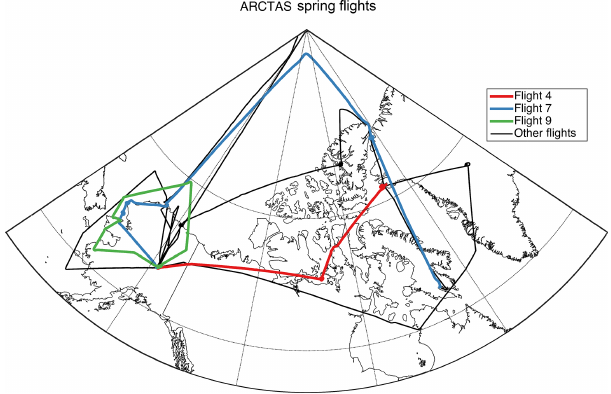
Figure 1. Map of ARCTAS-A flights over the North American Arc- tic. Highlighted flights correspond to flight data results analyzed in Fig.